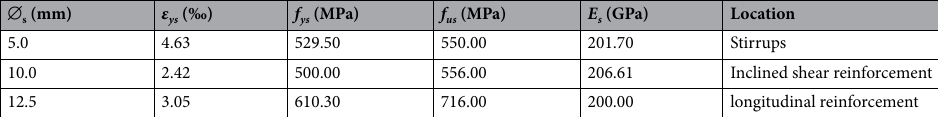
Table 4. Mechanical properties of the reinforcements used. ∅ s = steel bar diameter; ε ys = strains; f ys = yield stresses; f us = ultimate tensile strength of steel bar; E s = modulus of